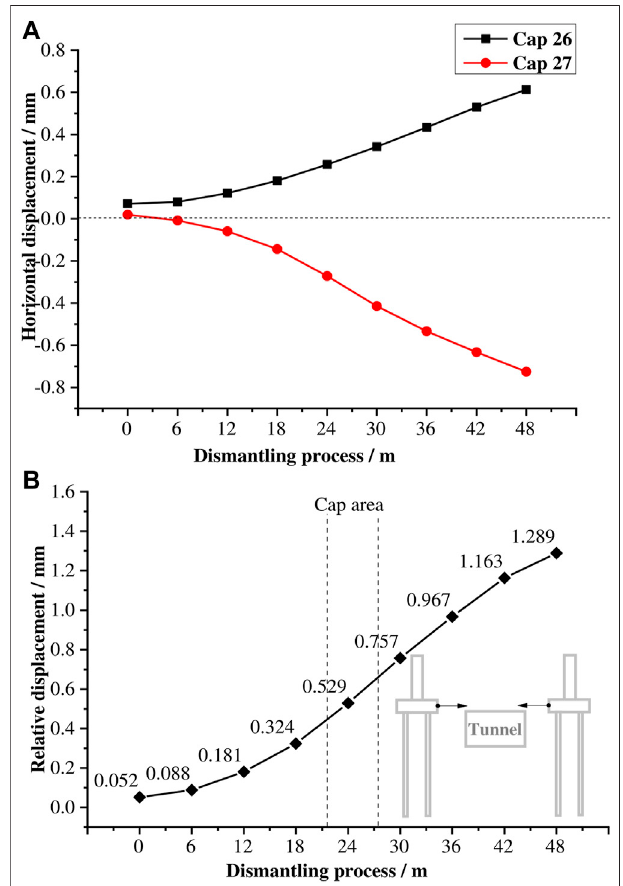
FIGURE 5 | Displacement of caps 26 and 27 during the dismantling process of temporary lining: (A) Horizontal displacement in the Y-direction; (B) Relative horizontal